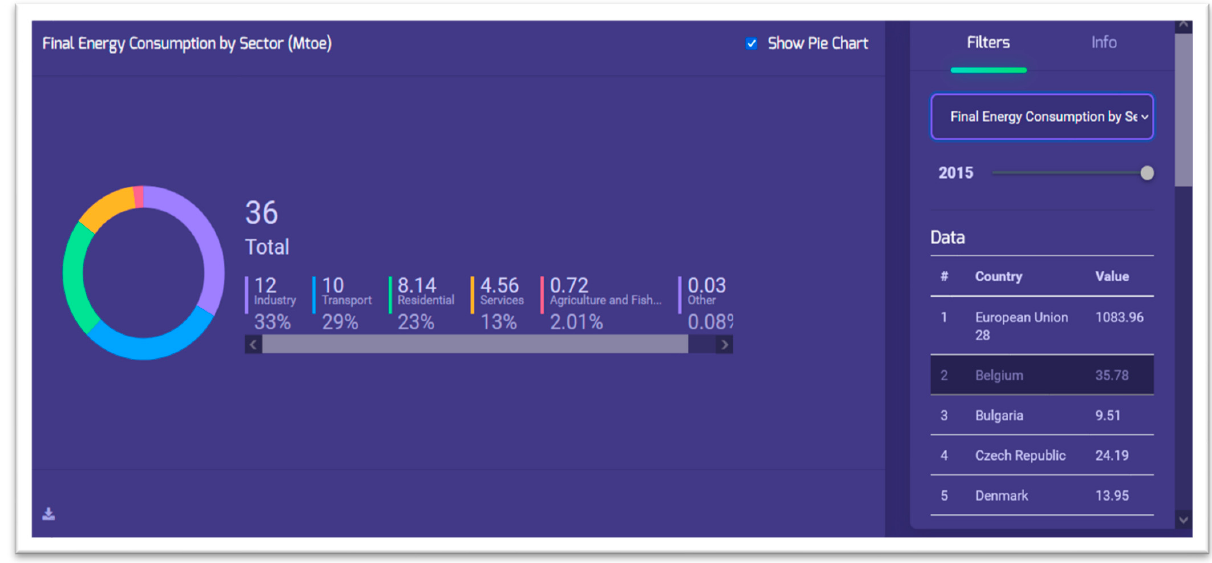
Figure 8. Final energy consumption by sector of an EU country.